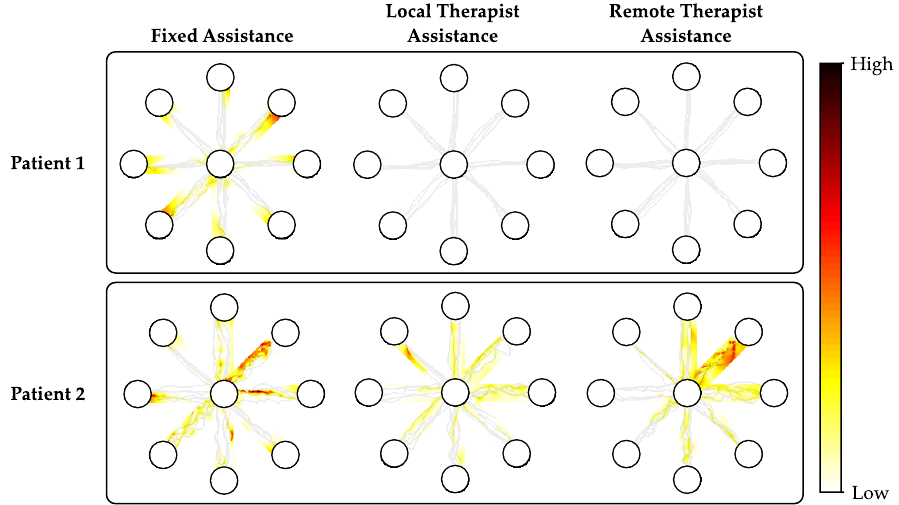
Figure 9. Example trajectories for two users, with overlaying density plots indicating the location and amount of the offered assistance. Darker areas indicate higher amounts of